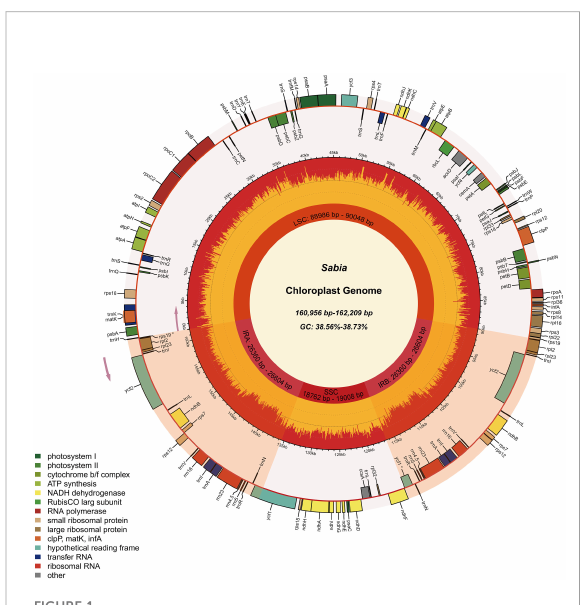
FIGURE 1 Chloroplast genome map of 11 Sabia samples. In the fi rst inner circle, the lengths of the corresponding large single-copy region, small single-copy region, and two inverted repeat regions of the chloroplast genomes of Sabia are given. In the second circle, the orange area denotes the GC content of each region, and the yellow area corresponds to the AT content. The distribution of genes is shown in the outermost circle, with pseudogenes marked with an asterisk. Genes are colored according to their function. The direction of transcription for the inner circle genes is clockwise, while that for the outer circle genes is